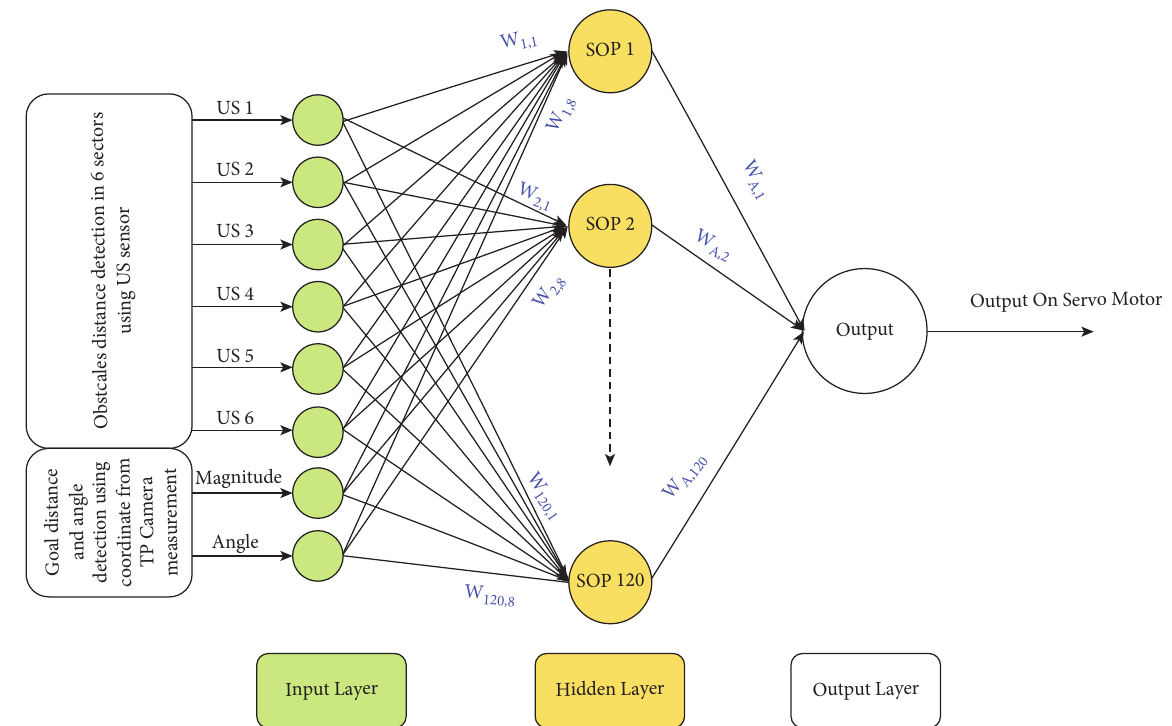
Figure 2: Three-layer neural network for robot navigation (neural network